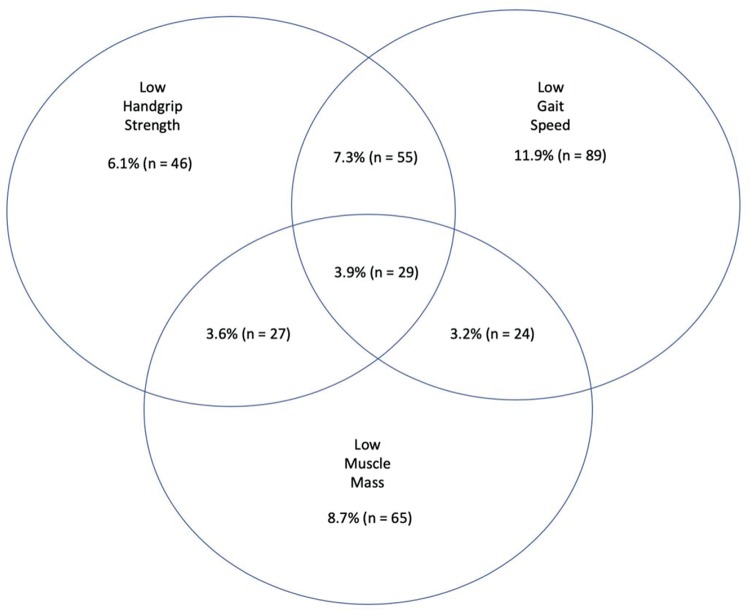
Venn diagram displaying the percentage of subjects [% (n)] who had low muscle mass and/or low handgrip strength and/or low gait speed amongst 745 individuals aged 65 years or older who are residents of the northern region of Rio de Janeiro, Brazil, 2010.